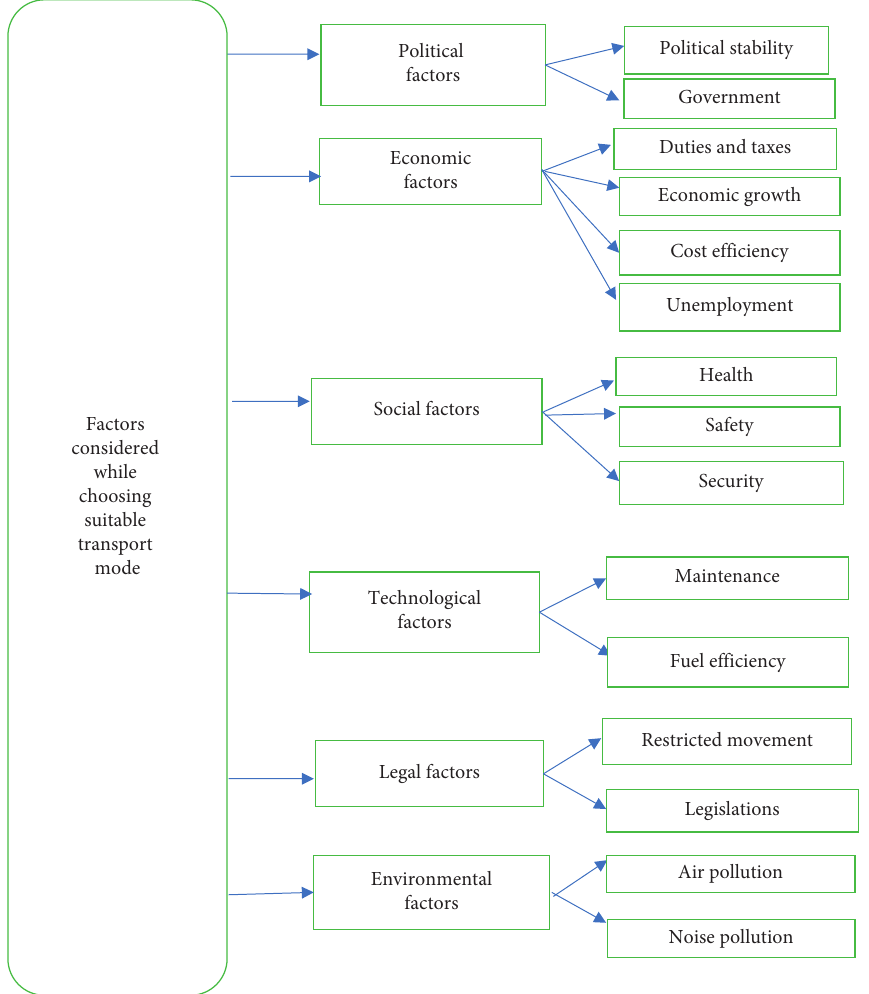
Figure 1: Factors that influence the vehicle mode